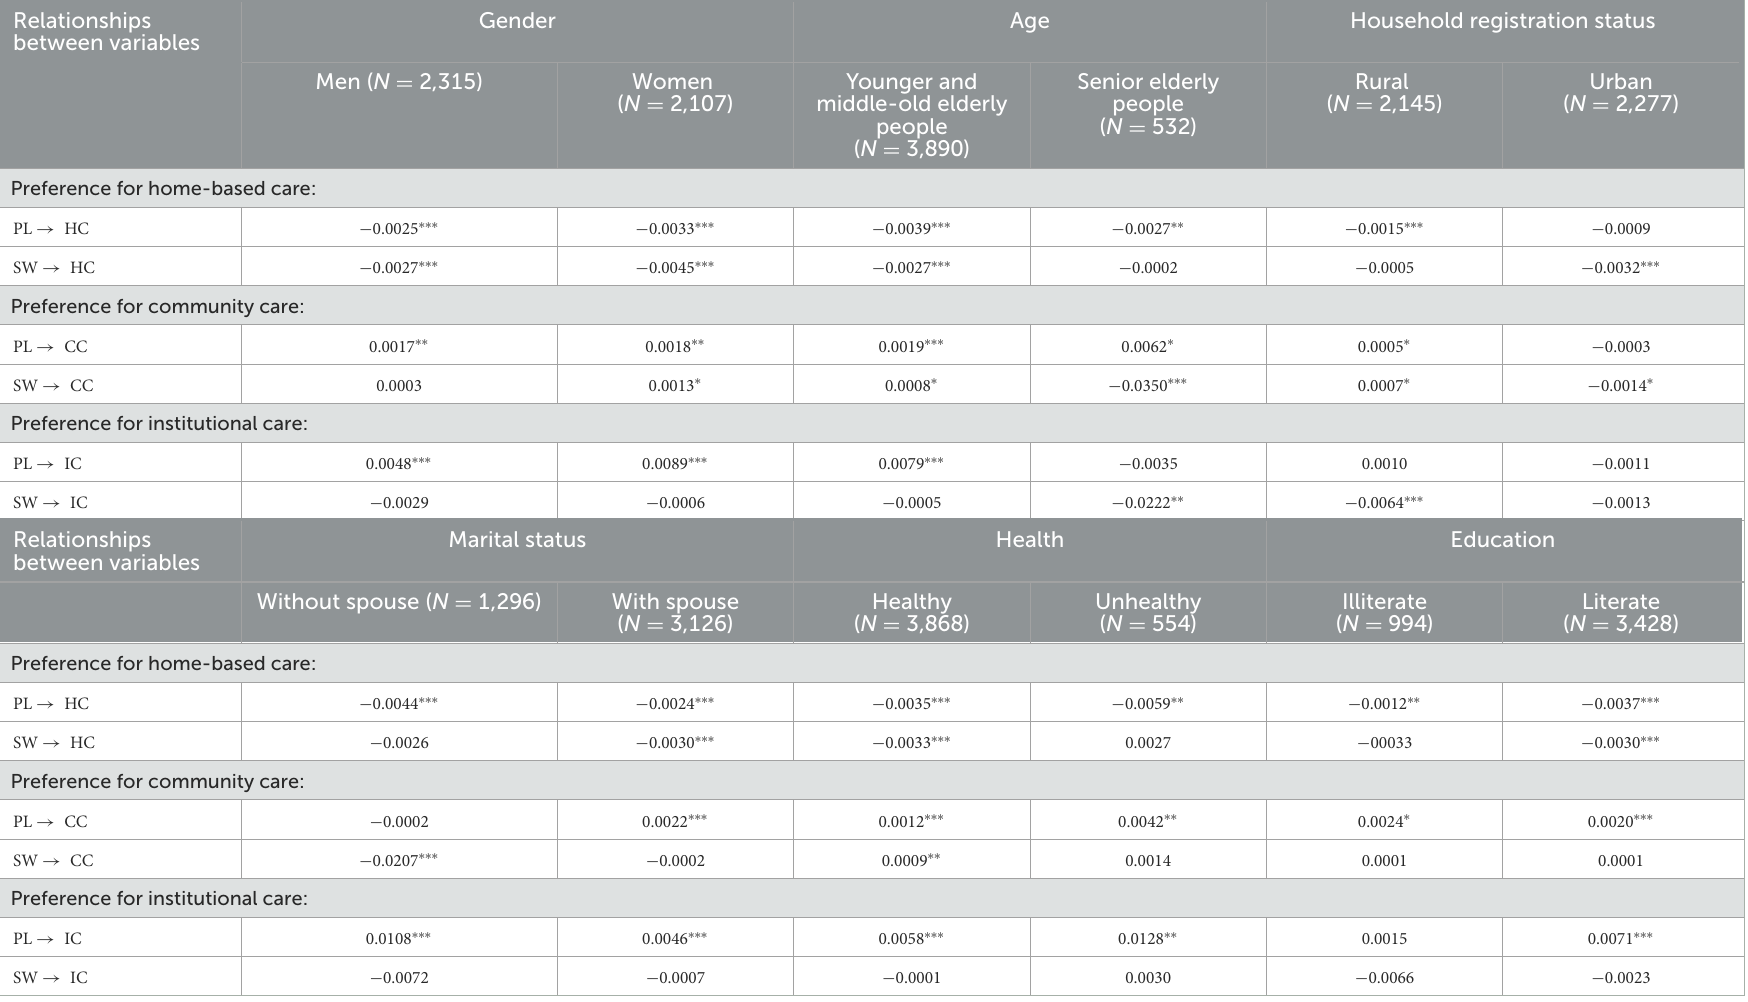
TABLE 6 Heterogeneity analysis. Relationships between